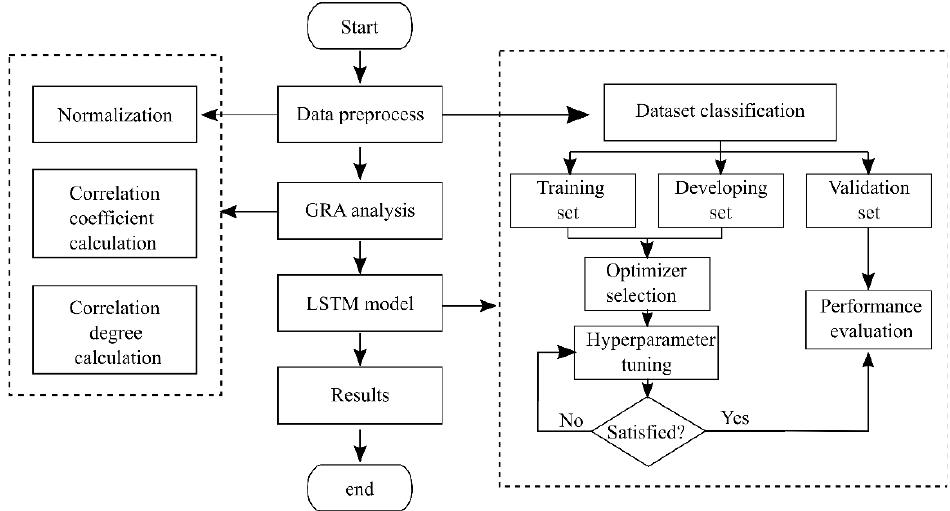
Figure 3. Flow chart of GRA-LSTM